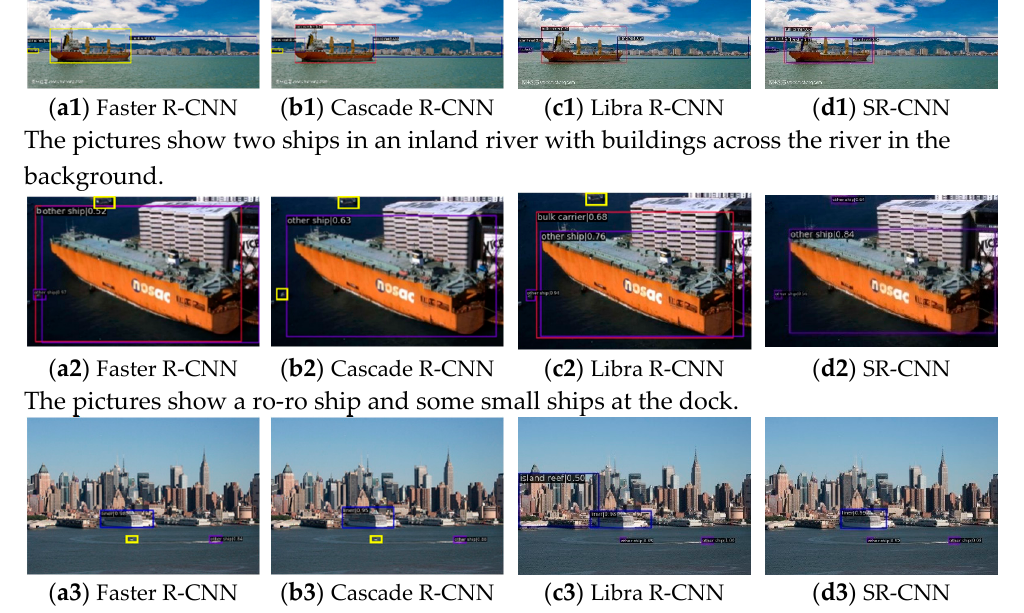
Figure 13. Comparison of ship detection algorithms in remote shore complex background. (Blue box is liner and yellow box is missed ship target).